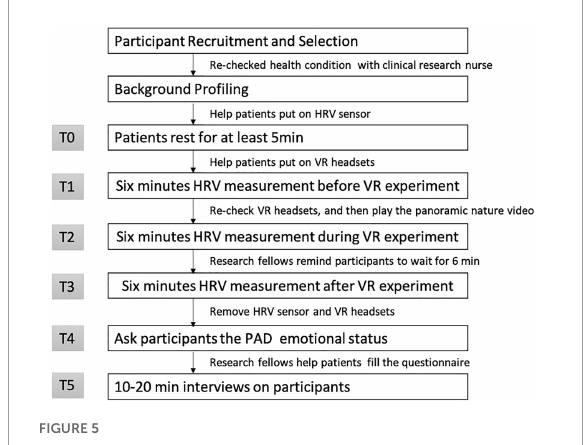
FIGURE5 Flow diagram for data collection in 360-degree nature video